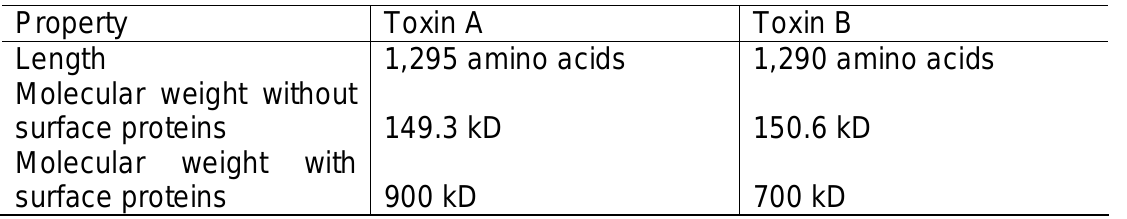
Table 1: Physical characteristics of toxins A and B